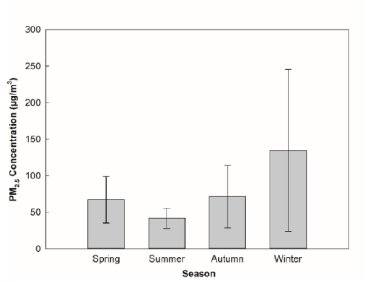
Figure3 Seasonal Variation Characteristics of PM 2.5 in Zhengzhou during